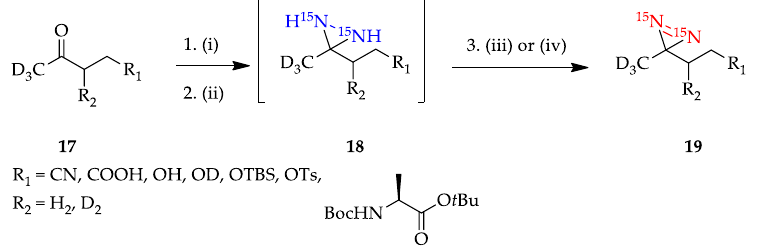
Figure 4. N 2 -diazirine molecular tags synthesis via 15 N 2 -diaziridine oxidation by conventional sys-